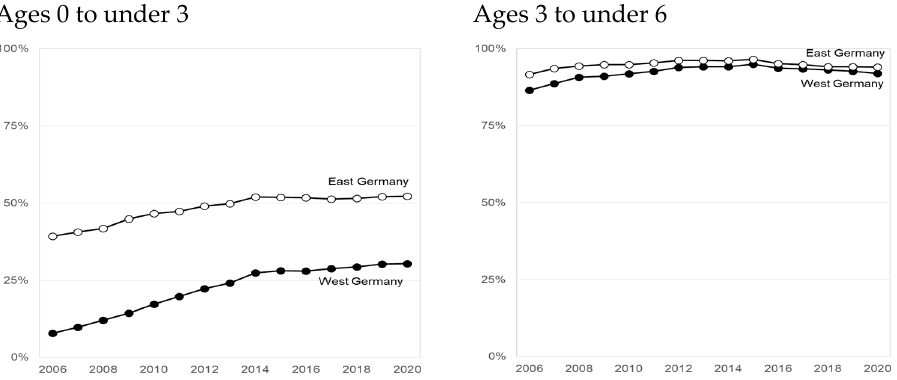
Figure 1. Usage of public day care by region and age of children. Source: Data compiled based on various publications of the German Statistical Office by akjstat. Note: These statistics include institutional child care as well as publicly funded child minders (Tagespflege).